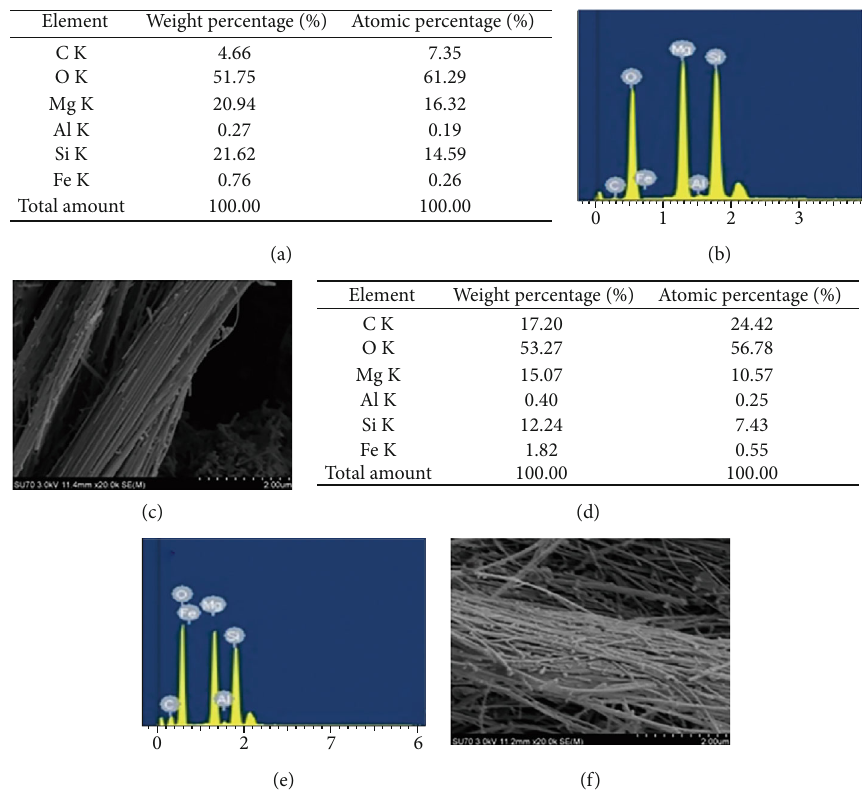
Figure 3: SEM and EDS: (a, b) EDS of Sep, (c) SEM of Sep, (d, e) EDS of Sep@Fe